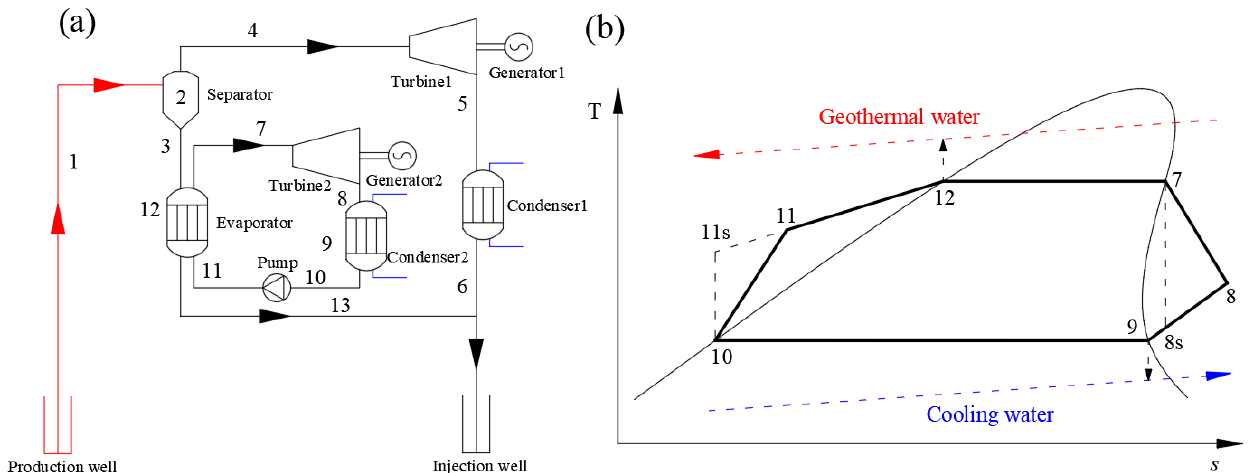
Figure 3. The schematic diagram and T-s diagram of the SFORC system. ( a ) schematic diagram; ( b ) T-s diagram.